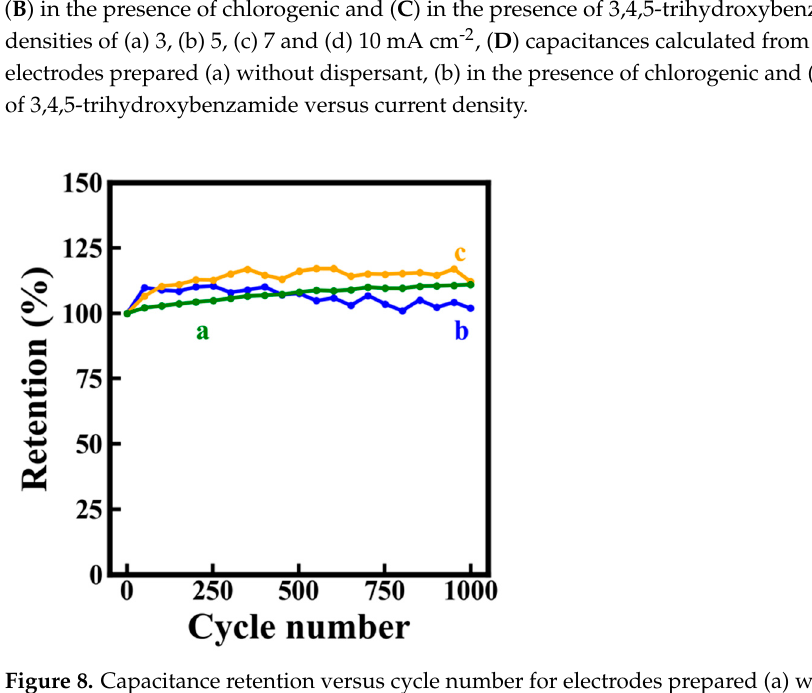
Figure 8. Capacitance retention versus cycle number for electrodes prepared (a) without dispersant, (b) in the presence of chlorogenic and (c) in the presence of 3,4,5-trihydroxybenzamide versus current density.